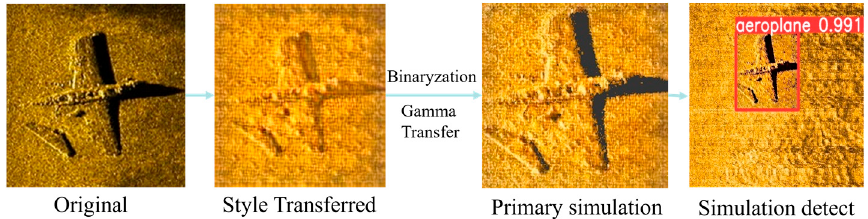
Figure 18. Real data verification process.